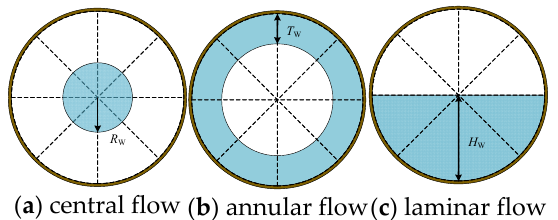
Table 3. Setting parameters of non-uniform ECT sensor simulation object field.